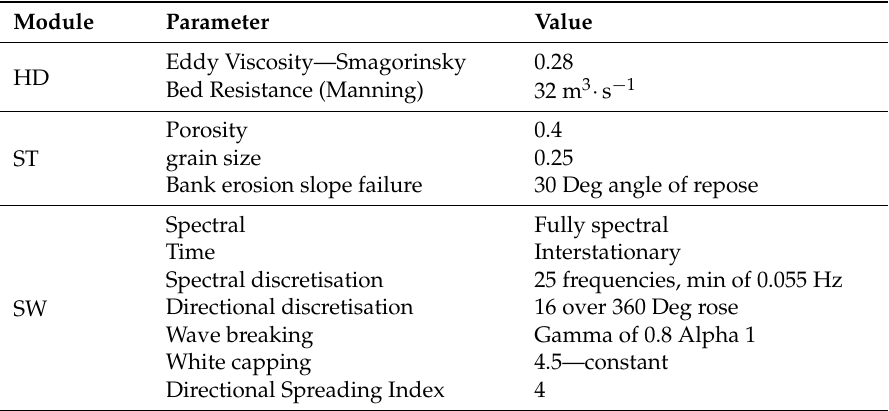
Table 3. Final model parameter